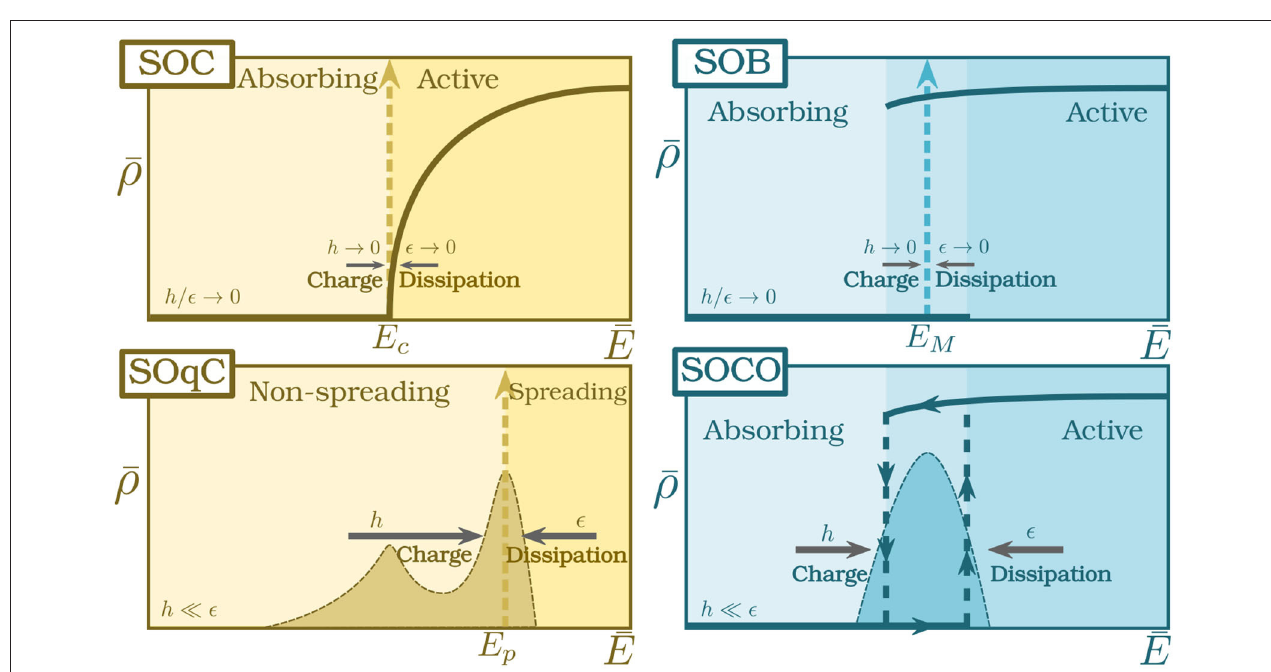
FIGURE 2 | Sketch of the different types of self-organization mechanisms discussed here. The four panels illustrate, respectively, the mechanisms for self-organization to a continuous phase transition with criticality (left panels) and to a discontinuous transition (right panels), for both the “perfect” conserved case (top panels) and the “approximated” or “imperfect” non-conserved case (bottom panels). In all cases the steady-state average activity is plotted as a function of the control parameter (the average “energy” or “stress”). The SOC and SOB mechanisms change dynamically the control parameter to a precise value (either E c or E M , respectively), meaning that the system becomes perfectly self-organized to the edge of a phase transition (either a continuous one for SOC or discontinuous one for SOB) in the thermodynamic limit. On the other hand, their corresponding “imperfect” or non-conserved counterparts—that we call “self-organized quasi-criticality” (SOqC) and “self-organized collective oscillations” (SOCO)—give rise to broad distributions of possible energy values, even in the thermodynamic limit, typically around the edge of the transition point (shown as an area enclosed by dashed lines). The thin arrows in the upper panels illustrate the fact that dissipation and driving rates are very small ǫ ). ( h 0, ǫ 0 with h /ǫ 0), while the thick ones indicate that such a strict limit is not taken, but still ( h → → → ≪ was questioned by using a possible counterexample [85].